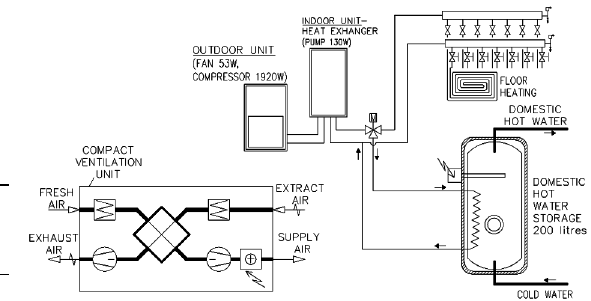
Fig. 1. Energy system of the low energy house in